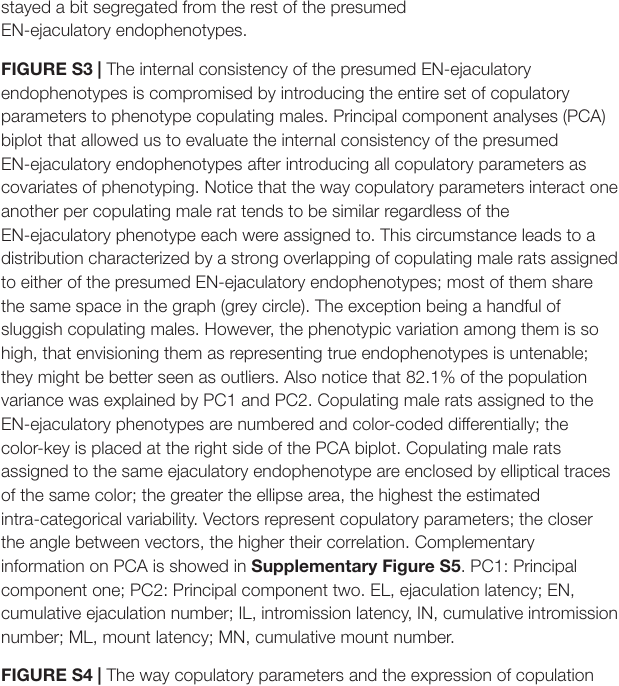
FIGURE S1 | Distribution of copulating male rats before phenotyping, relative to different copulatory parameters. Histogram plots constructed based upon the probability density that depict the distribution of copulator males ( n = 50), when classified based upon (A) ejaculation latency, (B) cumulative ejaculation number, (C) mount latency, (D) cumulative mount number, (E) intromission latency, and (F) cumulative intromission number. Even though ejaculation and intromission latency curves are slightly right-hand skewed, for the most part, our copulating male sample distributes normally relative to each of the copulatory parameters. So, we can safely say that we begin our study with an unimodal population of copulating male rats. FIGURE S2 | The internal consistency of the presumed EN-ejaculatory endophenotypes is compromised by introducing any other copulatory parameter in addition to EN as phenotyping variate. Boxplots and probability density plots allowed us to evaluate the internal consistency of the presumed EN-ejaculatory endophenotypes (B) after introducing as covariates of phenotyping ejaculation latency (A) , mount latency (C) , intromission latency (E) , cumulative mount number (D) , and cumulative intromission number (F) . When EN was used as the exclusive phenotyping variate, a fair segregation with virtually relatively little overlapping among the presumed EN-ejaculatory endophenotypes was observed (B) . In contrast, when EN was paired with mount latency (C) , intromission latency (E) , cumulative mount number (D) , and cumulative intromission number (F) , a great deal of overlapping occurred among the presumed EN-ejaculatory endophenotypes. Something similar happened when EN was paired with ejaculation latency (A) with the exception of the sluggish copulating males who stayed a bit segregated from the rest of the presumed EN-ejaculatory endophenotypes. FIGURE S3 | The internal consistency of the presumed EN-ejaculatory endophenotypes is compromised by introducing the entire set of copulatory parameters to phenotype copulating males. Principal component analyses (PCA) biplot that allowed us to evaluate the internal consistency of the presumed EN-ejaculatory endophenotypes after introducing all copulatory parameters as covariates of phenotyping. Notice that the way copulatory parameters interact one another per copulating male rat tends to be similar regardless of the EN-ejaculatory phenotype each were assigned to. This circumstance leads to a distribution characterized by a strong overlapping of copulating male rats assigned to either of the presumed EN-ejaculatory endophenotypes; most of them share the same space in the graph (grey circle). The exception being a handful of sluggish copulating males. However, the phenotypic variation among them is so high, that envisioning them as representing true endophenotypes is untenable; they might be better seen as outliers. Also notice that 82.1% of the population variance was explained by PC1 and PC2. Copulating male rats assigned to the EN-ejaculatory phenotypes are numbered and color-coded differentially; the color-key is placed at the right side of the PCA biplot. Copulating male rats assigned to the same ejaculatory endophenotype are enclosed by elliptical traces of the same color; the greater the ellipse area, the highest the estimated intra-categorical variability. Vectors represent copulatory parameters; the closer the angle between vectors, the higher their correlation. Complementary information on PCA is showed in Supplementary Figure S5 . PC1: Principal component one; PC2: Principal component two. EL, ejaculation latency; EN, cumulative ejaculation number; IL, intromission latency, IN, cumulative intromission number; ML, mount latency; MN, cumulative mount number. FIGURE S4 | The way copulatory parameters and the expression of copulation relevant genes in pertinent brain limbic areas interacts one another or altogether are not specific to either of the presumed EN-ejaculatory endophenotypes. (A) A complete linkage clustering dendrogram was used to estimate the degree of similarity among EN-phenotyped copulating males based on the way copulatory parameters interacted one another per phenotyped rat across the entire population of EN-phenotyped males ( n = 50). Notice that the population including some very low copulating male rats, threshes mixed down through the